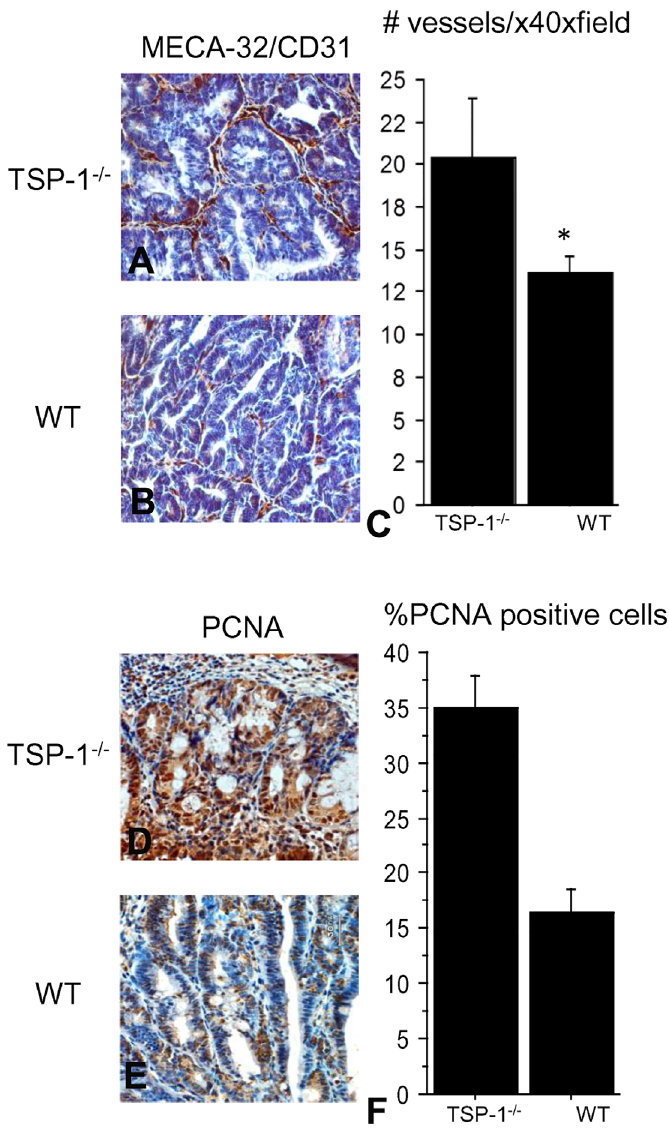
Fig 2. Analysis of microvascular density (MVD) and proliferation in TSP-1 -/- and WT tumors. Blood vessels were blindly evaluated in each tumor section stained with MECA and CD31 antibodies in TSP-1 -/- (A) and WT colons (B). Tumors lacking TSP-1 showed significantly higher MVD as compared to the MVD in the WT tumors (p = 0.0159), (C). IHC for PCNA was performed and positive nuclei were counted in the tumor sections of TSP-1 deficient mice (D) and WT mice (E). PCNA rates were significantly higher in tumors of TSP- 1 -/- mice compared to WT tumors (p < .0001),